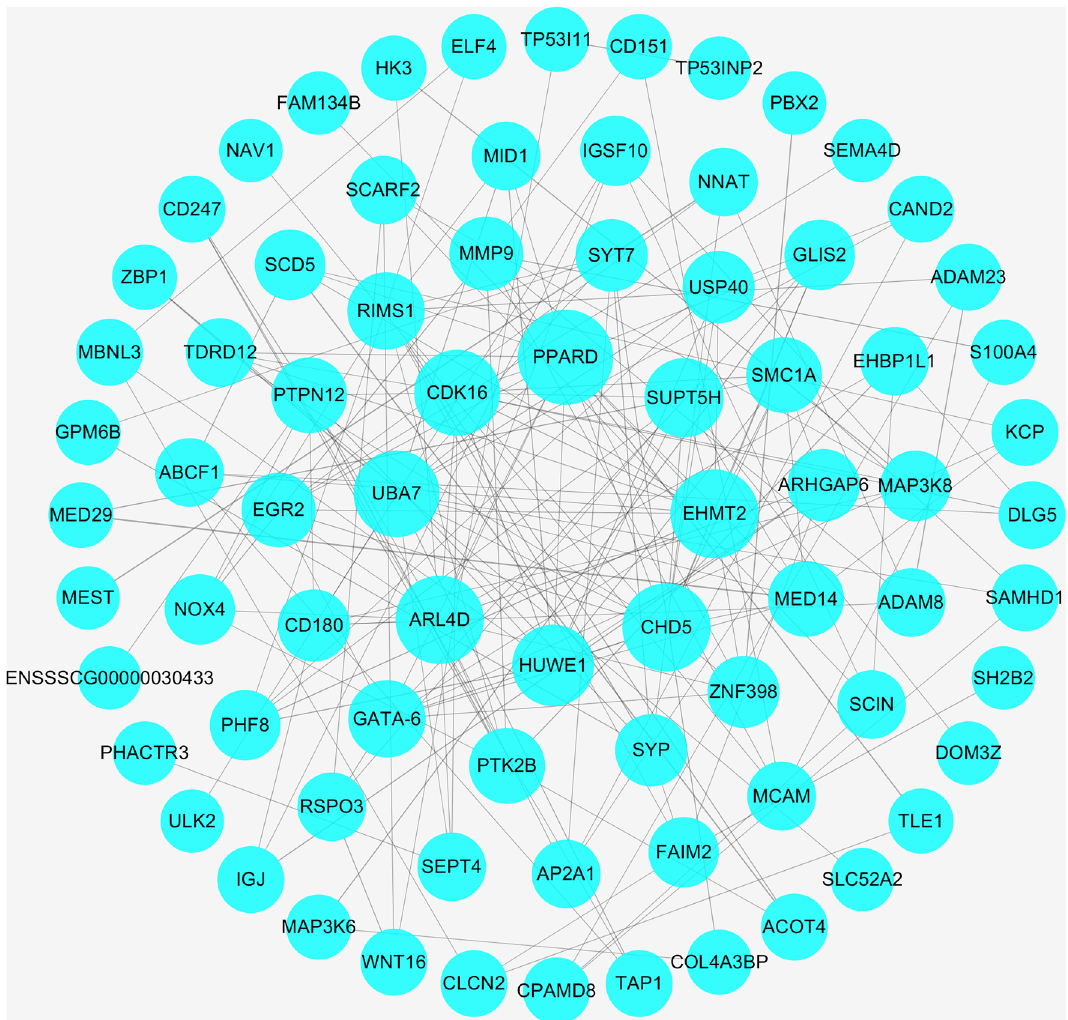
Figure 7. Protein–protein interaction network between top 300 downregulated and up-regulated DEGs in L_JN and L_PX by threshold p-value < 0.05, |log2fold change|≥ 1. The node size represents